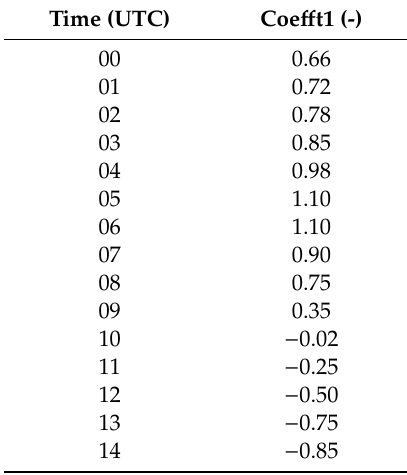
Table 1. Coe ff t1, as a function of the time of the